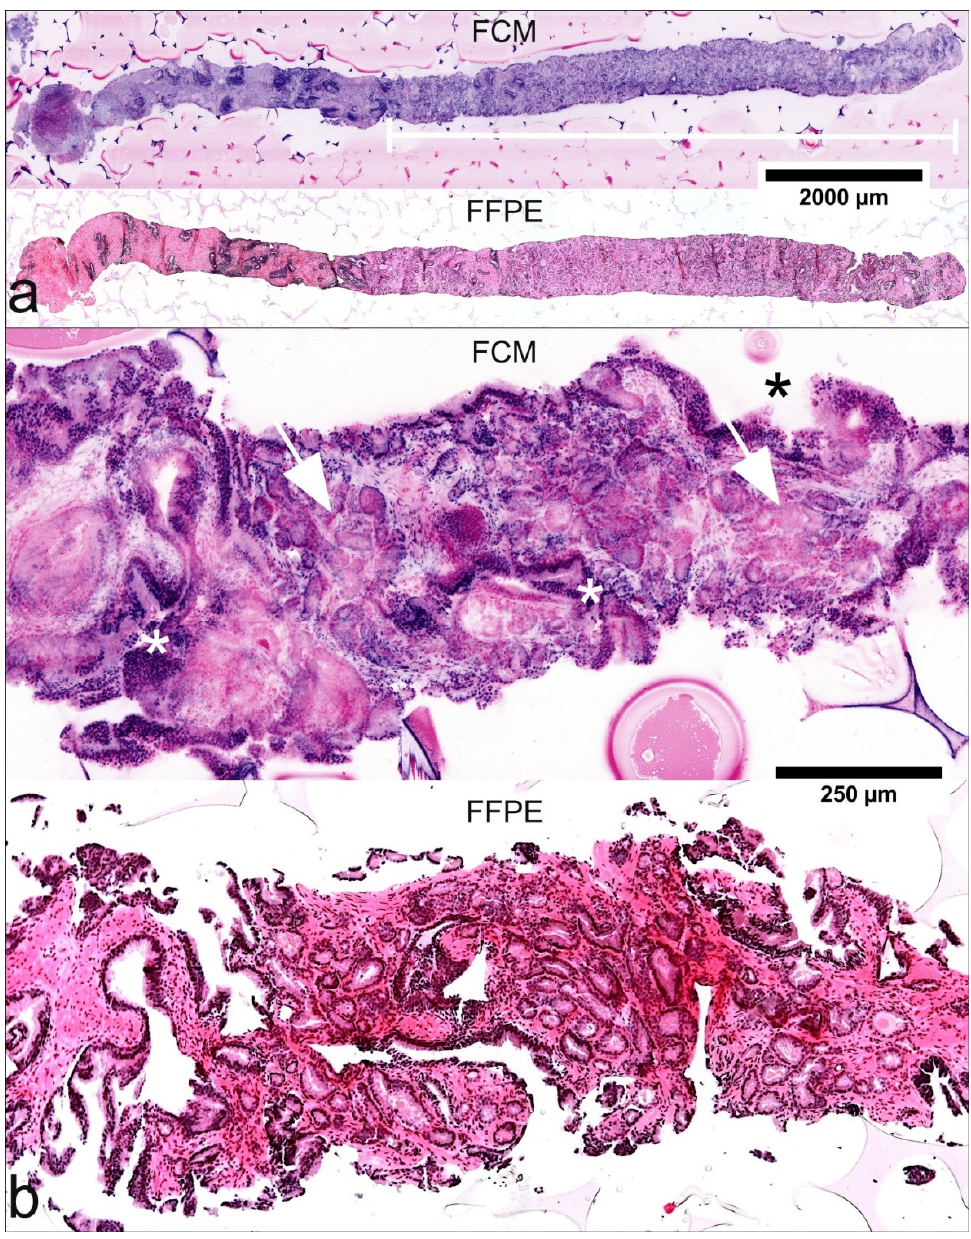
Figure 1. Histological criteria of malignancy in FCM-images and FFPE-processed slides. ( a ) A biopsy of 12-mm length (P28-16) in low magnification. Pre-existing prostatic tissue shows peri-glandular inflammation. The white bar marks well differentiated tumor glands of 7.5 mm length (GLEASON Score 3 + 3; infiltration grade 62.5%). ( b ) FCM-scan and FFPE-processed material of another biopsy (P01-08) show features of infiltrative growth pattern with variable spacing between glands and changing calibers of pre-existing (*) and neoplastic glands (arrows) in higher magnification.